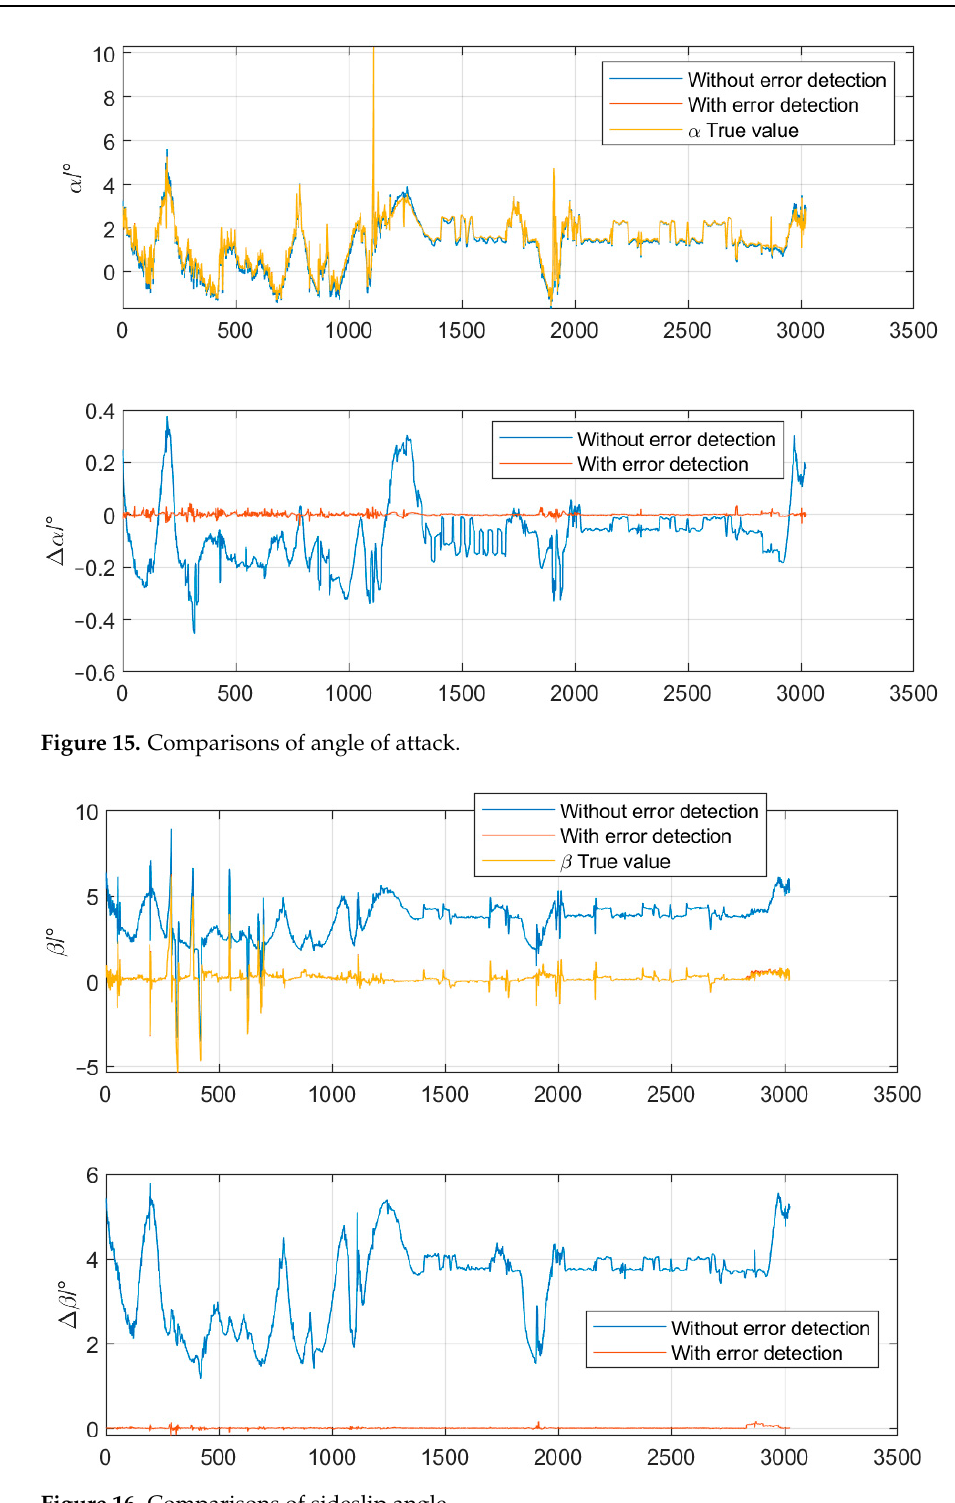
Figure 17. Comparison of Mach numbers. 6. Conclusions A mathematical model of an FADS system for an unmanned flying wing was devel- oped in this study. To find the best locations outside the leading-edge area for the pressure transducer, the mean impact value (MIV) was used, and upon comparing the prediction error with the cost function method [21], it showed less average and maximal error. En- semble neural networks were developed to predict the airdata with limited inputs. It was found that the artificial neural networks trained by the PSO method with the maximal error as the fitness function could achieve superior overall prediction accuracy. Further- more, a fault port detection method was developed based on artificial neural networks